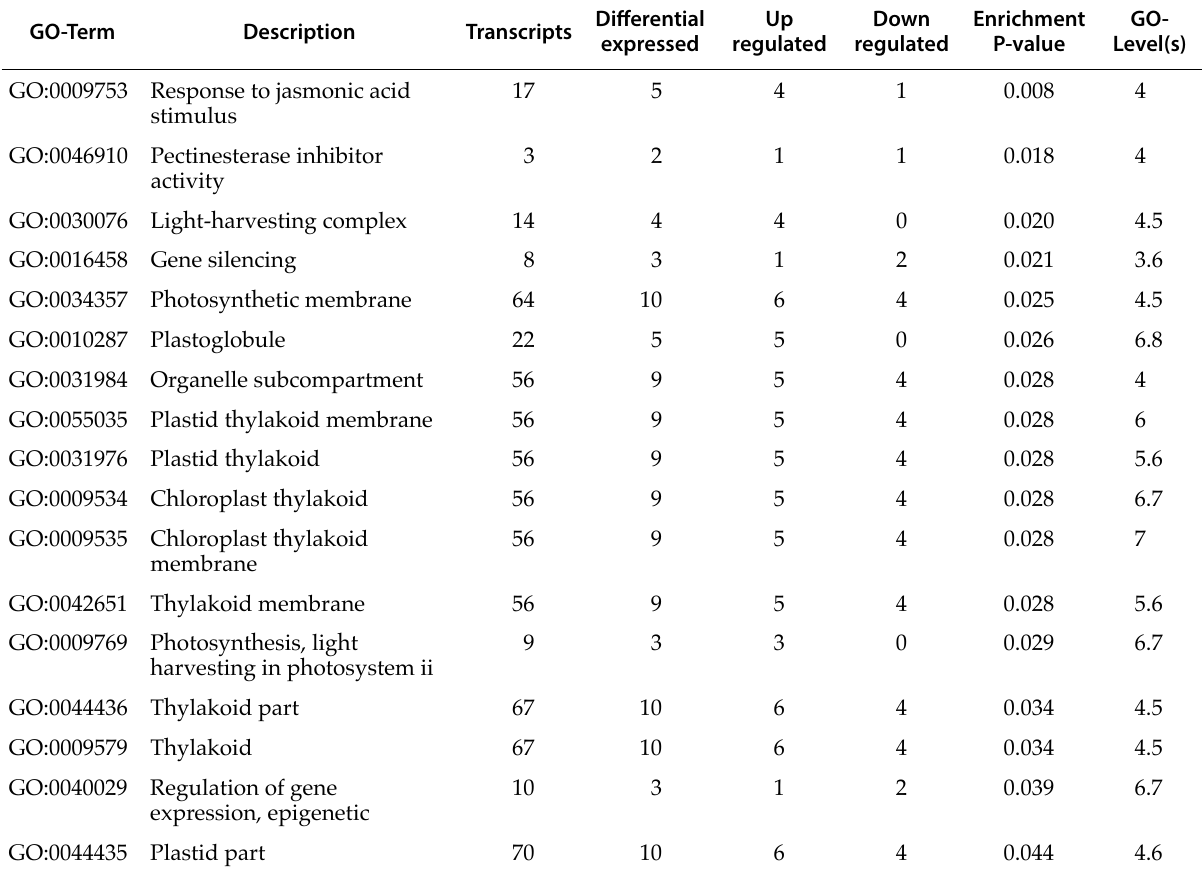
Table 4. List of the most enriched Go terms showing the number of differentially up and down-regulated Tags found on each